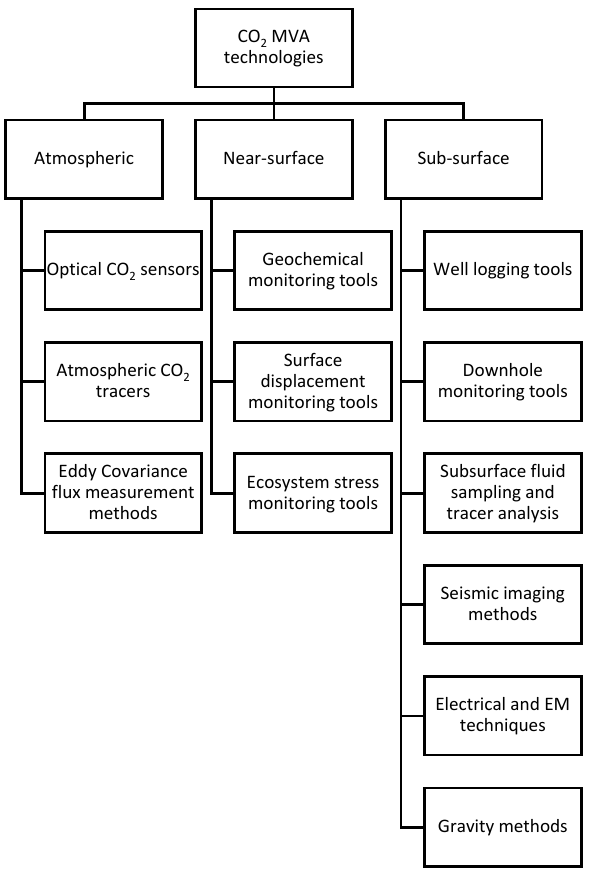
Figure 4. Various CO 2 monitoring, veri fi cation, and accounting technologies.